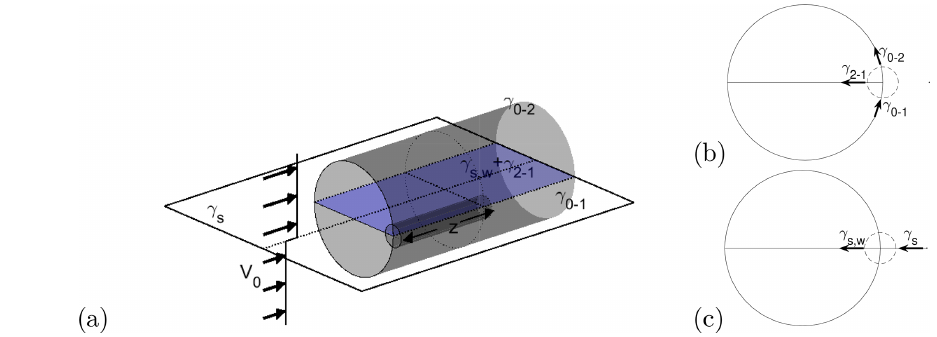
Figure 9. (a) A 3D sketch of the control volume used for computing the axial vorticity. (b, c) Front view with outline of the tangential vorticity stemming from the wake (b) and shear (c)